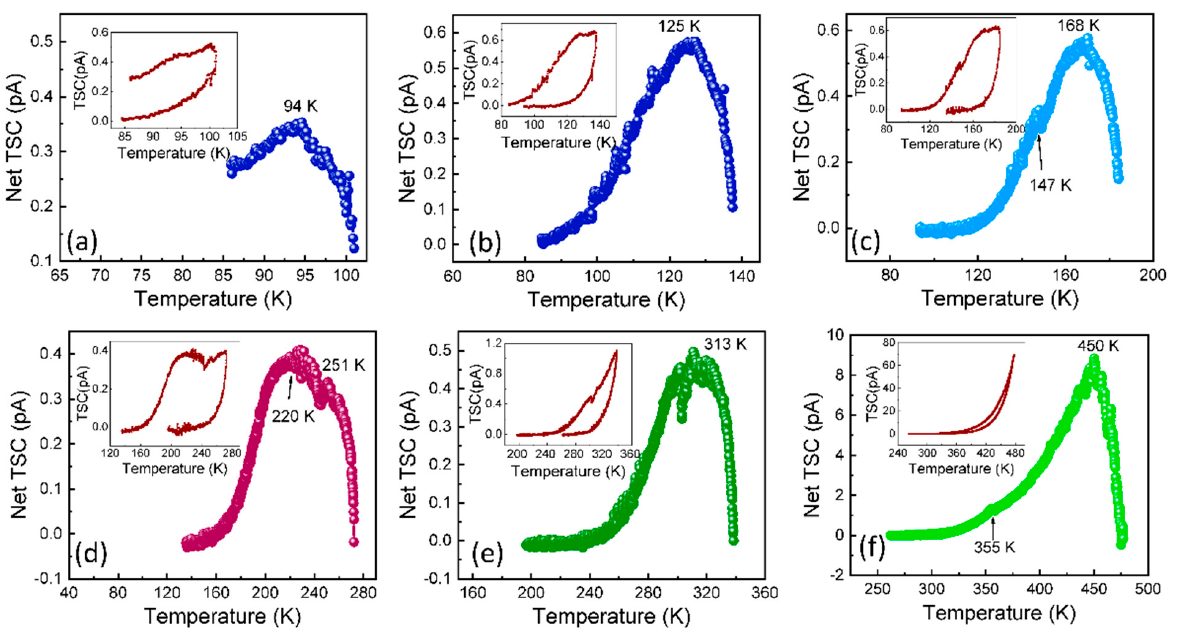
Figure 5. Net TSC peaks of all the traps with characteristic peak temperature ( a ) 94 K ( b ) 125K ( c ) 168 K, ( d ) 220 and 251 K, ( e ) 313 K and ( f ) 450 K.